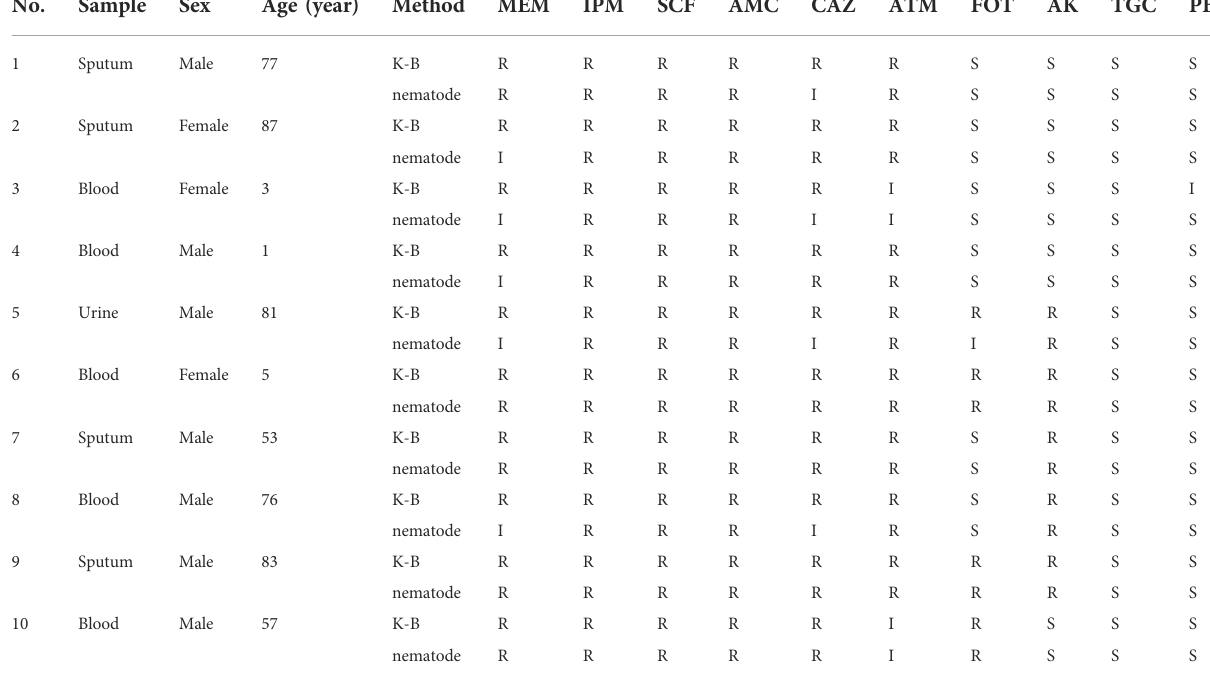
TABLE 3 Antimicrobial susceptibilities of 10 CRKP strains obtained from patients. No.